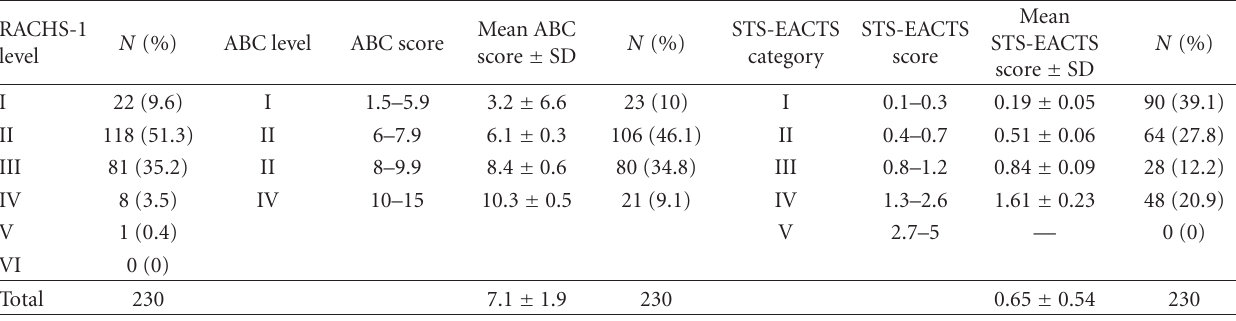
Table 3: Distribution of cases by the RACHS-1 risk categories, the Aristotle basic complexity levels, and STS-EACTS mortality categories. RACHS-1